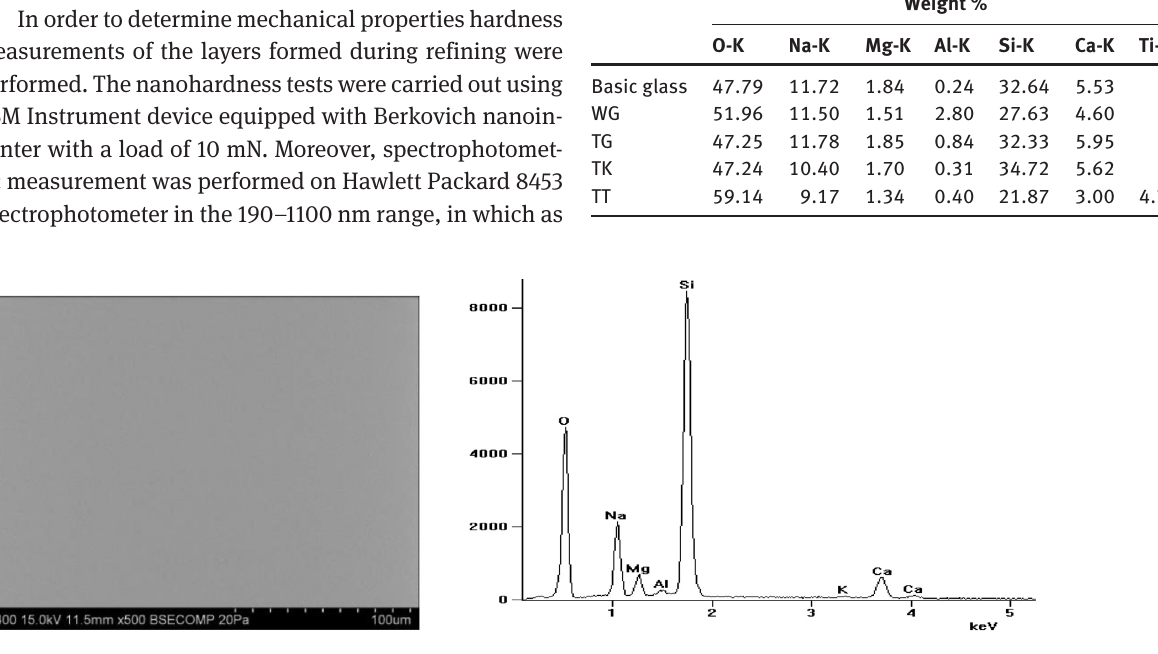
Fig. 1: Results of microstructure and EDS/SEM analysis of basic